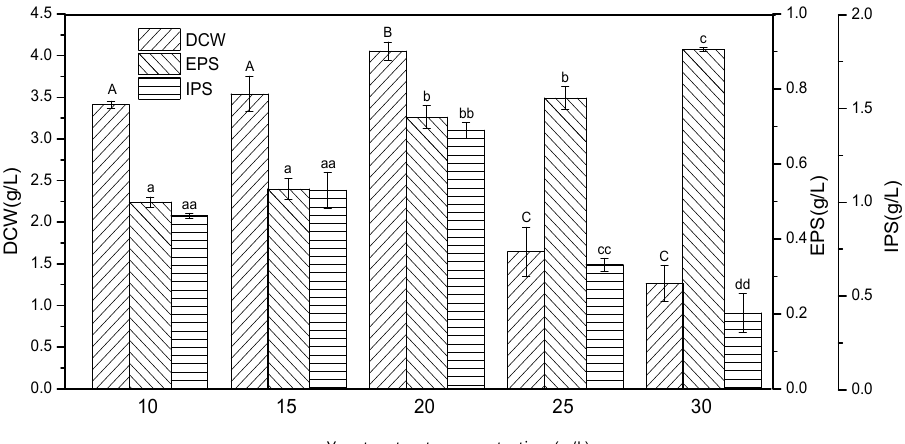
Figure 4. Effect of different yeast extract concentrations on mycelial growth (DCW: dry cell weight) and polysaccharides (EPS: exopolysaccharide; IPS: intracellular polysaccharide) production. The letters above bars are the same indication as shown in Figure 1.